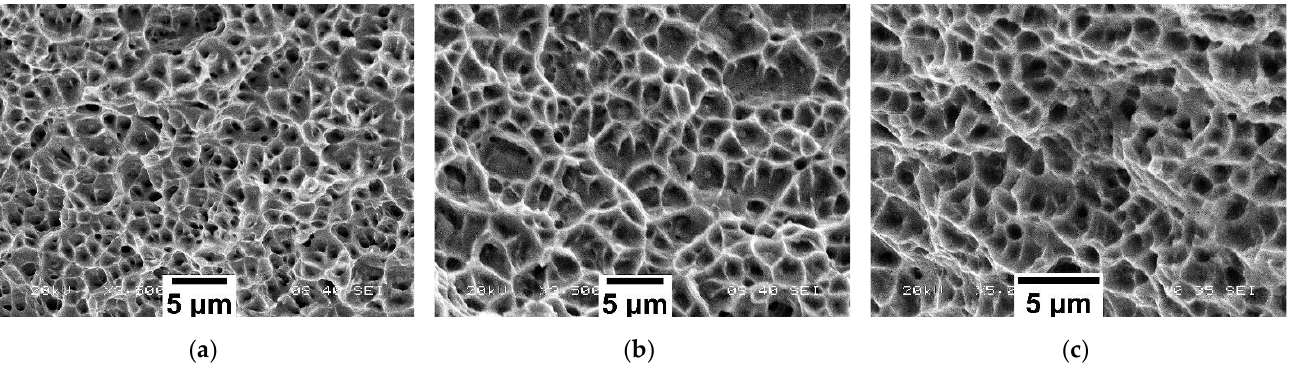
Figure 21. SEM micrographs of the fractured surface after ( a ) the tensile test, ( b ) compression test on SHORT honeycomb, ( c ) compression test on LONG honeycomb.